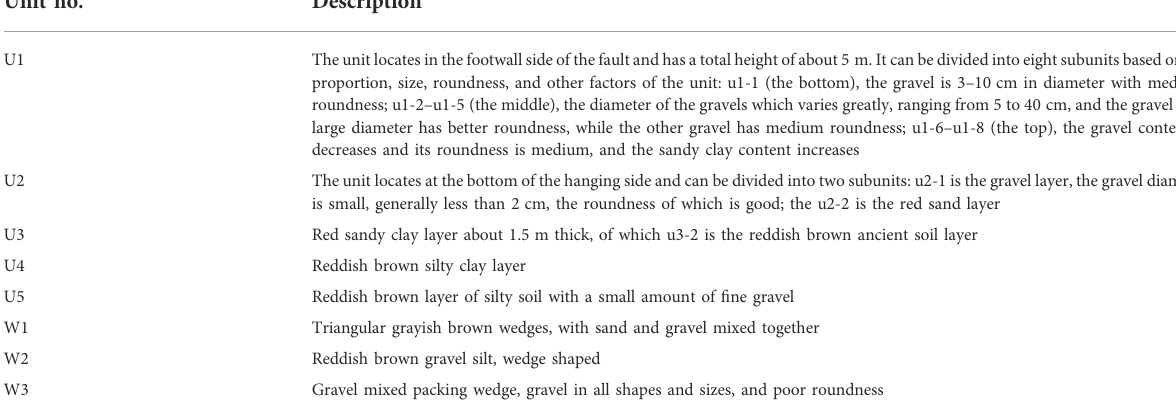
TABLE 3 Unit descriptions from the exposed walls of the Luofengwa trench. Unit no.